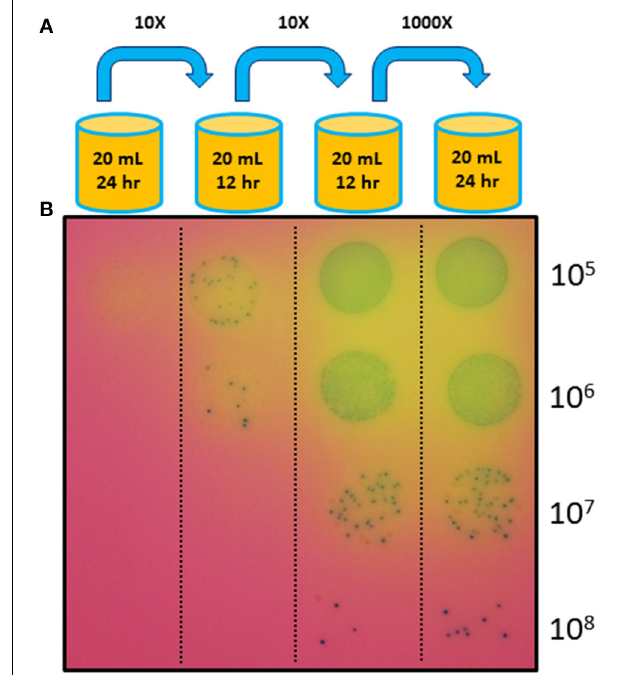
FIGURE 4 | Complementation using the marker-less approach. (A) Transformed mycoplasma cells were grown without any antibiotic selection in liquid culture through three serial passages with the dilution levels and culture durations indicated. After a new culture was started, the previous culture was stored at 4 ◦ C. (B) After the fourth culture, cells from each of the four successive cultures were diluted and plated on agar medium (also not containing any antibiotic) with X-gal to visualize the colonies. The enrichment of fast-growing colonies in later cultures suggests that the transformed and complemented cells overtook the population during later